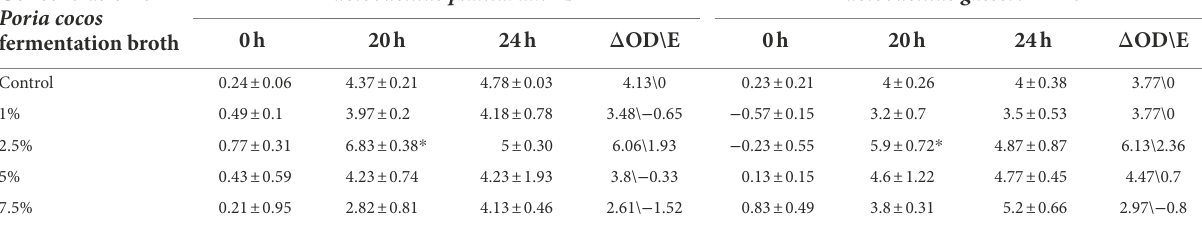
TABLE 1 Absorbance (optical density, OD) of the Lactobacillus plantarum R9 and Lactobacillus gasseri B1-27 fermentation broths with different concentrations of Poria cocos fermentation broth. Concentration of Poria cocos